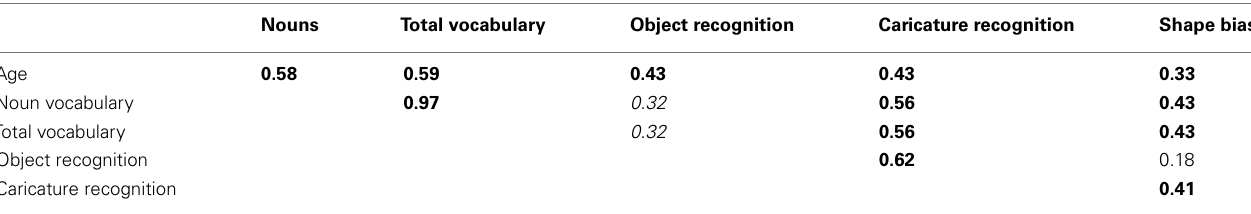
Table 2 |The pairwise linear correlations among the variables in Experiment